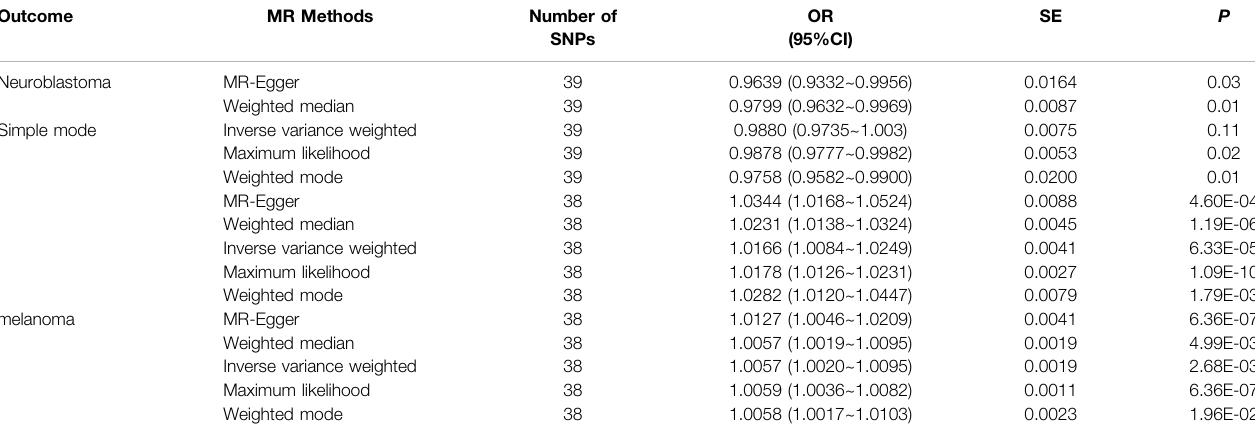
TABLE 2 | MR estimates for each method to assess the effect of TL on skin aging and skin cancer.